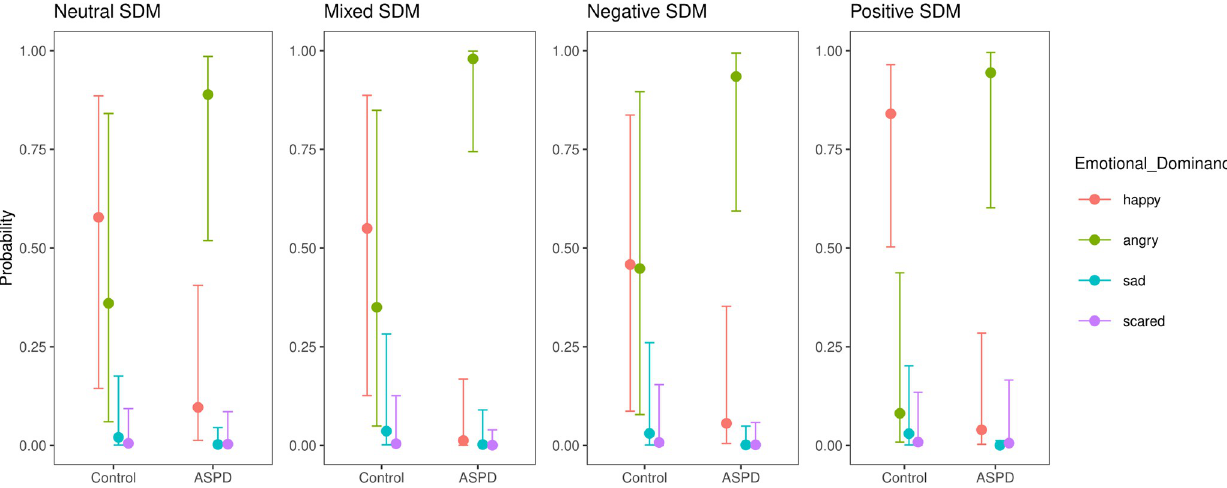
Fig 3. Posterior distribution of the mean with a median point estimate and 95% credible interval (thinner outer lines) of Model 4 (R/conditional effects R, [49]).